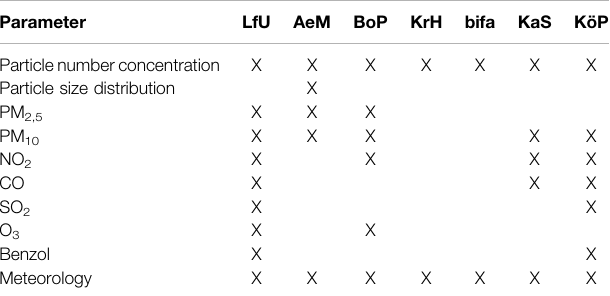
TABLE 1 | Recorded air quality parameters at the measurement sites in 2017.